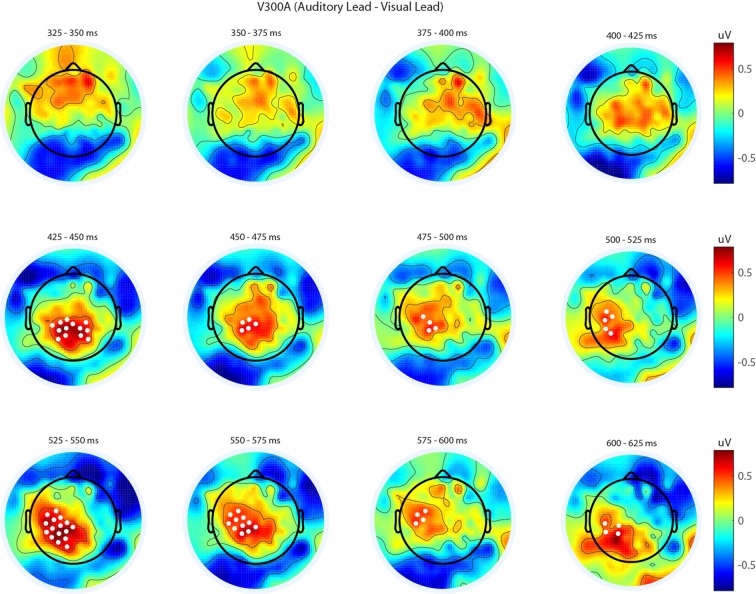
Spatiotemporal representation of evoked differences in the V300A condition. Cluster permutation testing indicated there was a single significant cluster (p = 0.00089). Voltages indicated are the difference between when trial t−1 was auditory leading and when trial t−1 was visual leading. Warm colors indicate voltage was greater when the preceding trial was an audio-leading trial. Cool colors indicate voltage was greater when vision-lead on the preceding trial. White circles indicate the locations of electrodes forming a significant cluster.